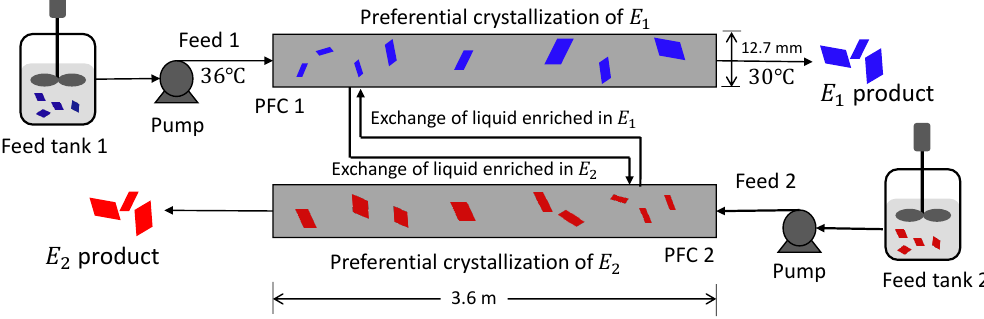
Figure 2. Schematic of the proposed coupled PFC (Plug flow crystallizer) configuration with liquid phase exchange.